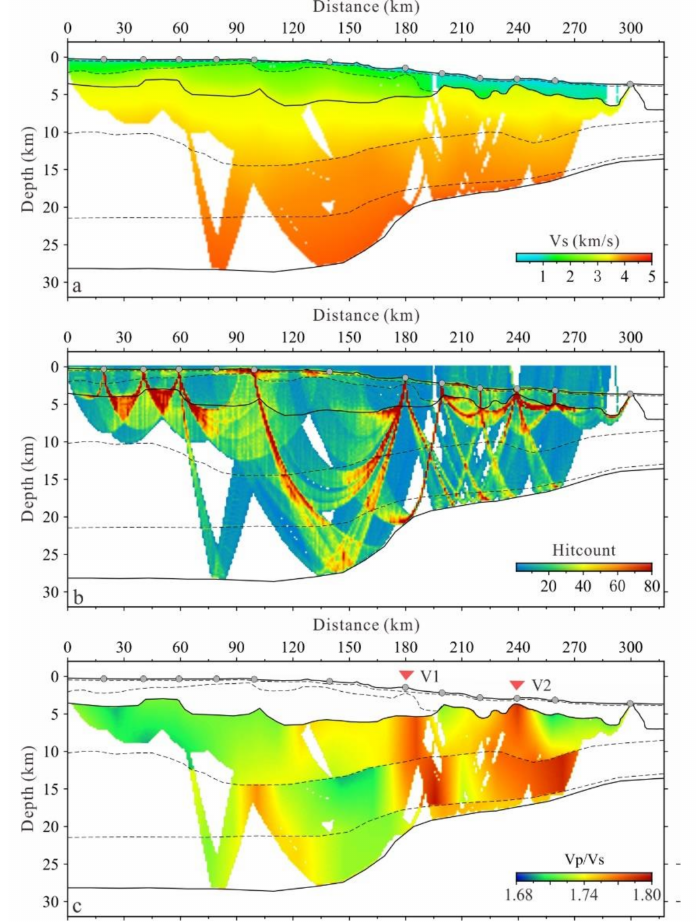
Figure 11. ( a ) The final inversion result for crustal S-wave velocity model. ( b ) Ray coverage density distribution, and the dimensions of counting grid are 1 × 0.25 km. ( c ) Apparent crustal Vp/Vs model that calculated by dividing the P-wave model by the inverted S-wave model ( a ). V1, V2 represent the buried volcanos